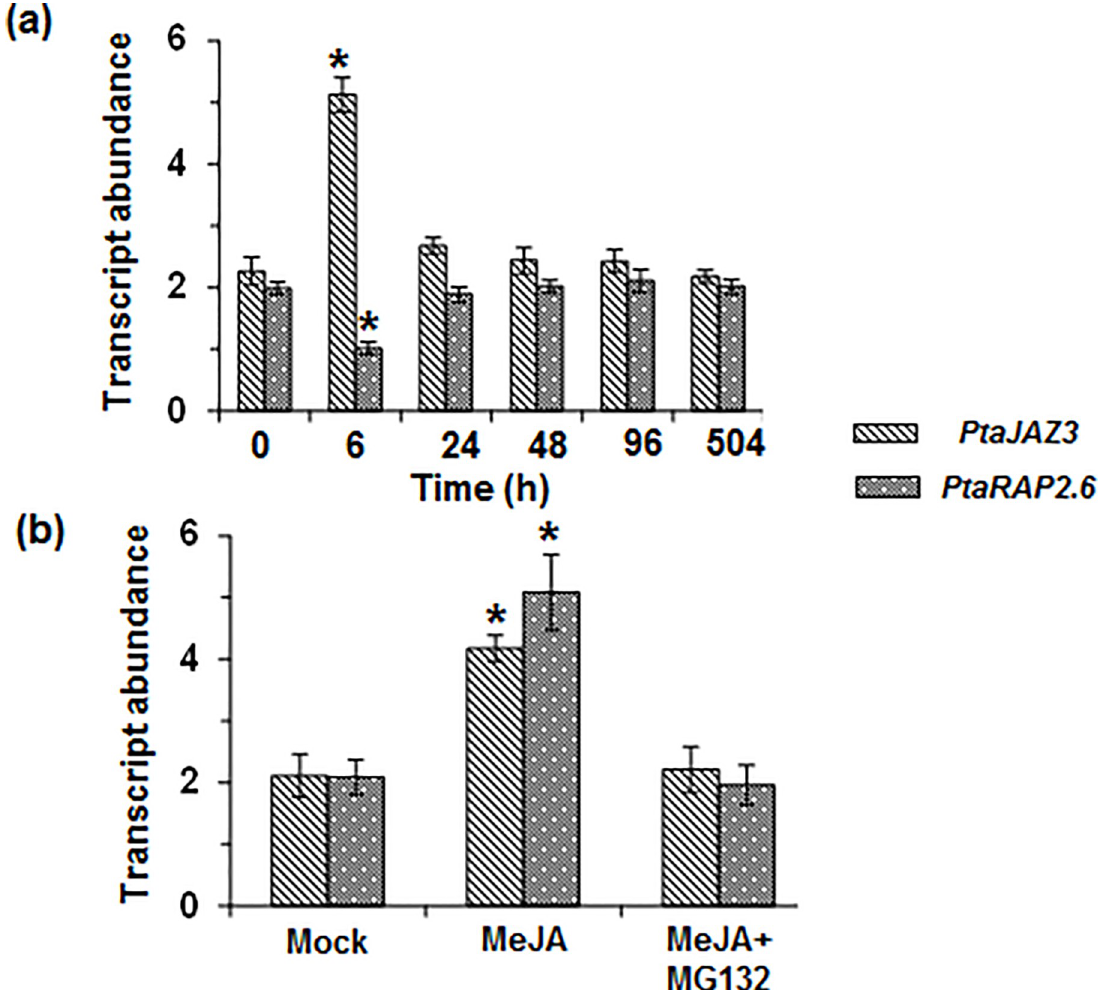
Fig 6. Drought stress and methyl jasmonate treatment affect PtaJAZ3 and PtaRAP2 . 6 expression. (a) Transcript levels of PtaJAZ3 and PtaRAP2 . 6 in response to PEG-induced drought stress. Poplar roots grown in control and PEG liquid media (see experimental procedures) were used for qRT-PCR analysis. Values are show as mean ± standard error of mean (SEM) ( n = 2). Asterisks represent statistical significant levels of differences between control and PEG treatment ( P < 0.05) calculated using Student’s t test. (b) PtaJAZ3 and PtaRAP2 . 6 are induced in response to methyl jasmonate (MeJA) treatment but the induction of both genes was abolished in presence of proteasome inhibitor, MG-132. Transcript levels were analyzed in poplar root samples treated with 0.2% DMSO (mock), 100 μ M MeJA and 100 μ M MeJA+ 80 μ M of MG-132 (see experimental procedures). Values show as mean ± standard error of mean (SEM) ( n = 2). Asterisks represent the treatments that are statistically different from the mock treatment ( P < 0.05) calculated using Student’s t test.